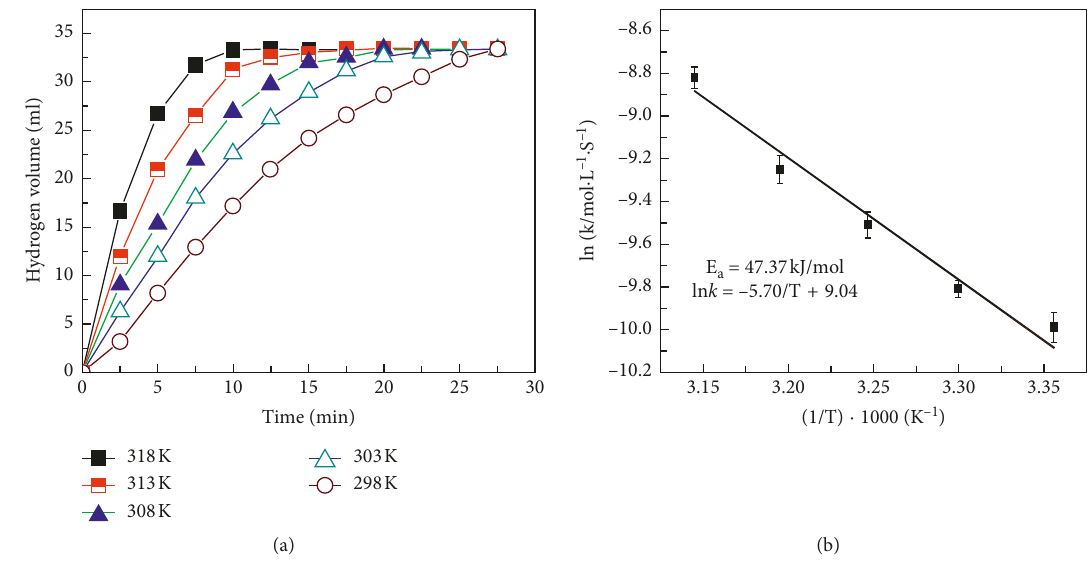
Figure 4: (a) Kinetic features of the hydrolytic dehydrogenation reaction catalyzed by the NiB/CNTs at different temperatures; (b) re- lationship between the logarithm of the hydrolysis reaction rate constant k and inverse of temperature T